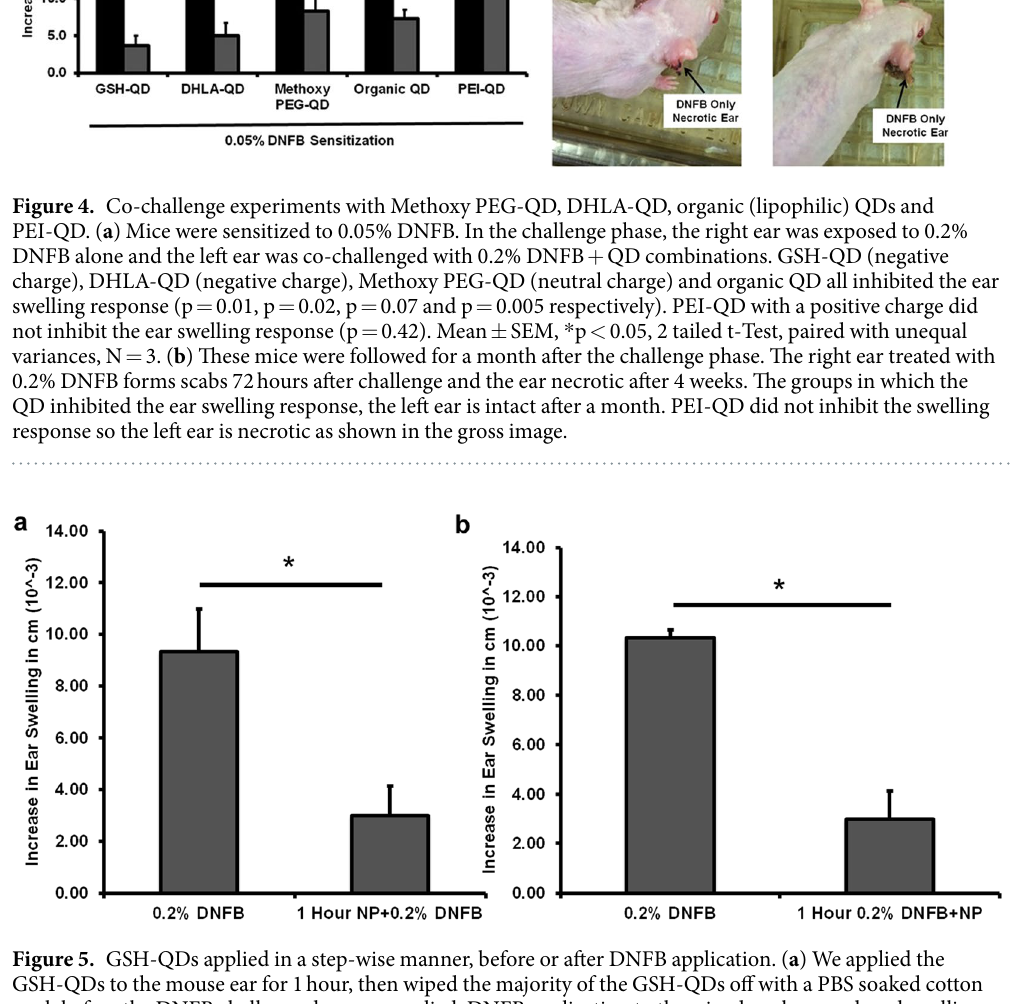
response. Furthermore, we tested poorly soluble carbon nanotubes (CNT) and titanium dioxide (TiO 2 ) which both exacerbated the swelling response. The above results were confirmed by H&E stained ear sections (Supplementary Figure S6 ) . The TiO 2 response is not unexpected, as it is widely known that TiO 2 NPs agglomer- ate on the skin surface and a recent study reported that topical application of nano-TiO 2 particles to mouse ears induced an irritation swelling response in a dose dependent manner 37 .